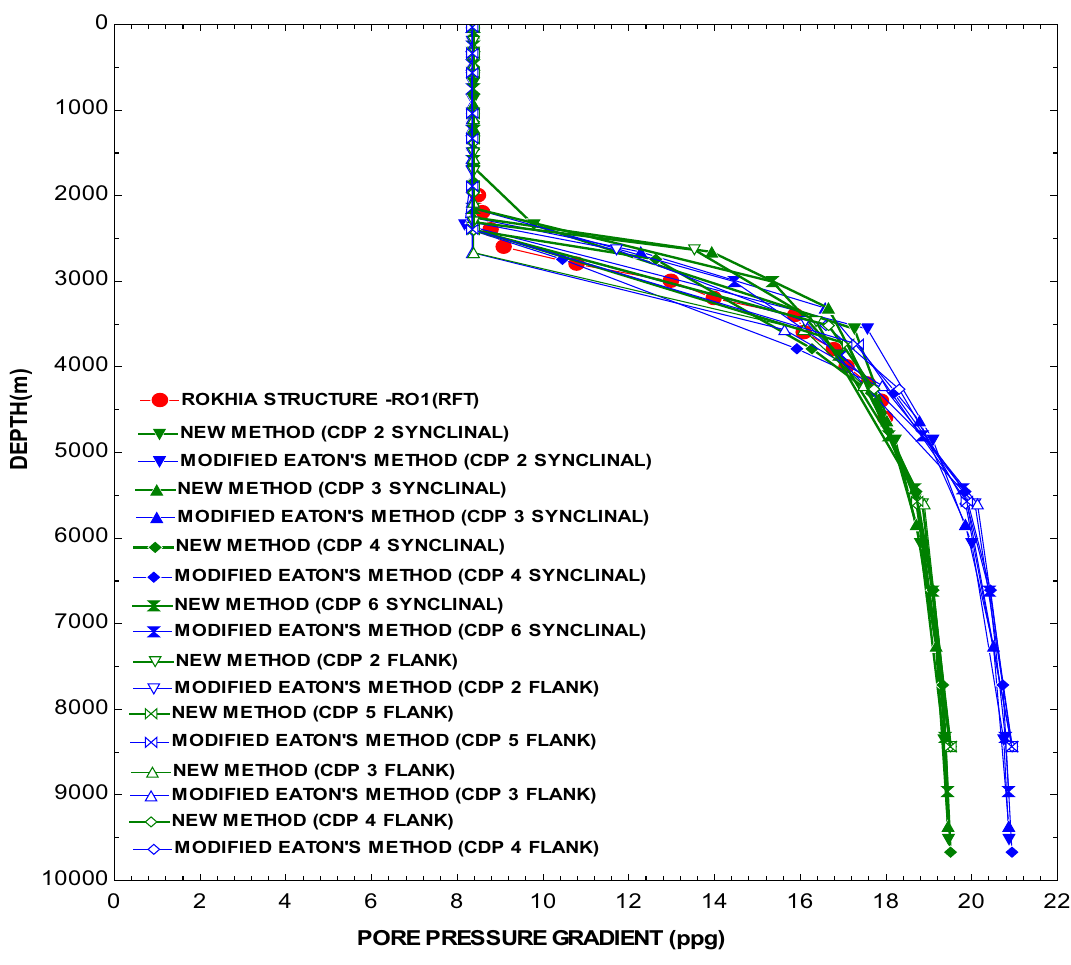
Fig. 7 RFT and predicted pore pressure by new method and modified Eaton’s method. (Rokhia